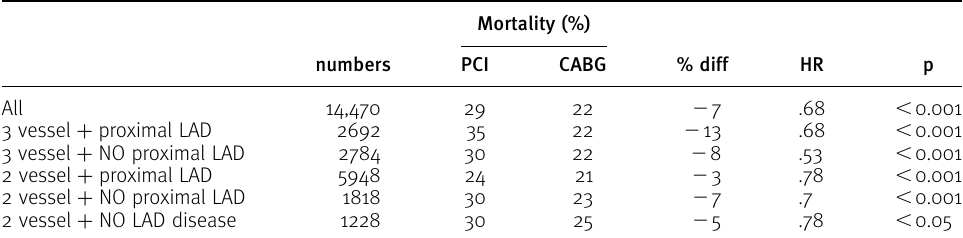
Table 2. 8-Year Mortality following PCI or CABG (Reference